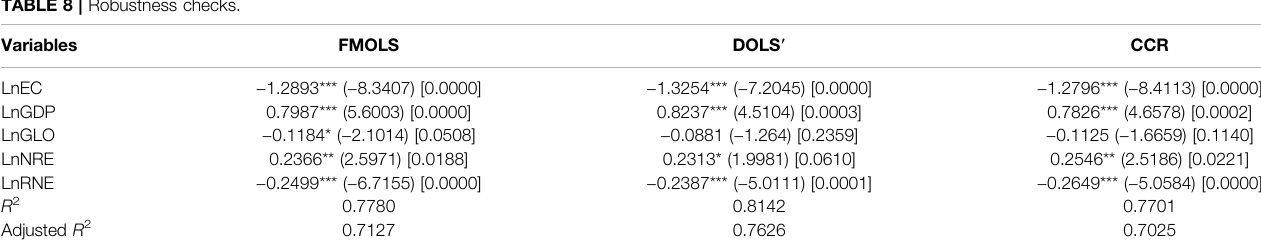
TABLE 8 | Robustness